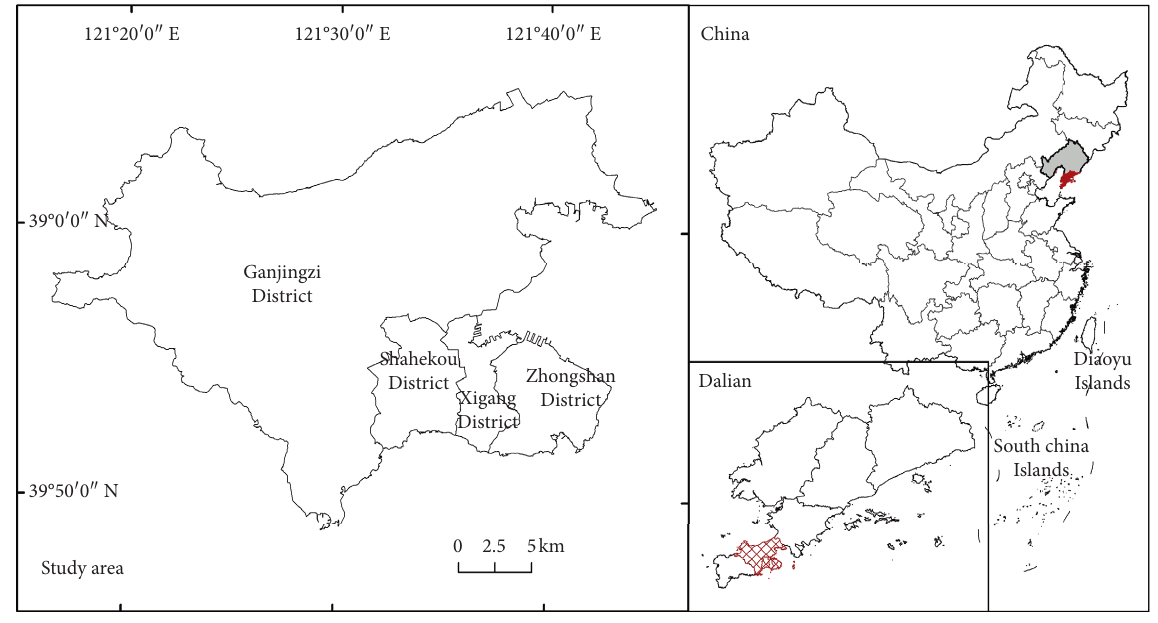
Figure 1: Location of the study